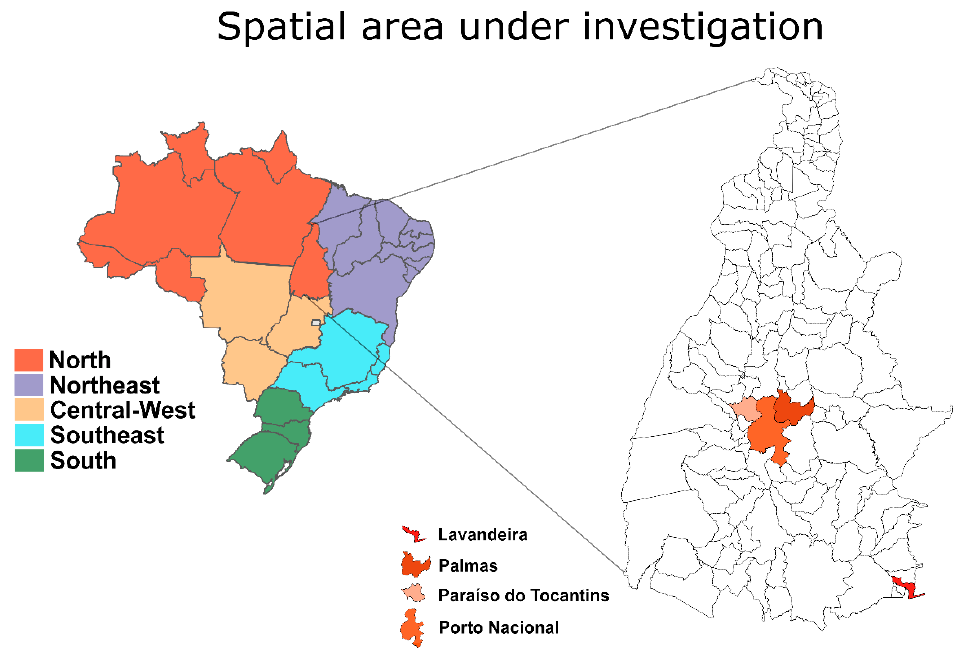
Figure 1. Political map (MOU1) of Brazilian regions with highlights on the Tocantins state, showing locations of the origin of the patients in which the CHIKV genomes reported in this study were collected. The figure was generated using R v4.1.2 with the following packages: ggplot2, geojsonio, sf, broom, and dplyr, and manually edited using Inkscape (GNU GPL v1.2; See http://www.inkscape.org. Accessed on 12 September 2022).